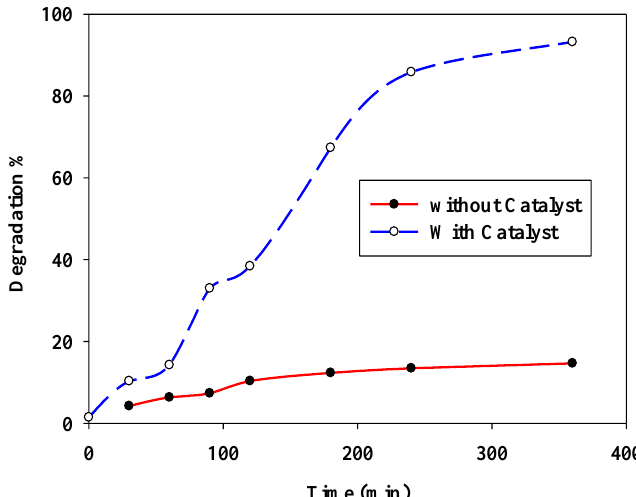
Figure 4. The effect of time on the degradation percentage of Direct Red 83 dye without using a catalyst and with using 0.3 g of